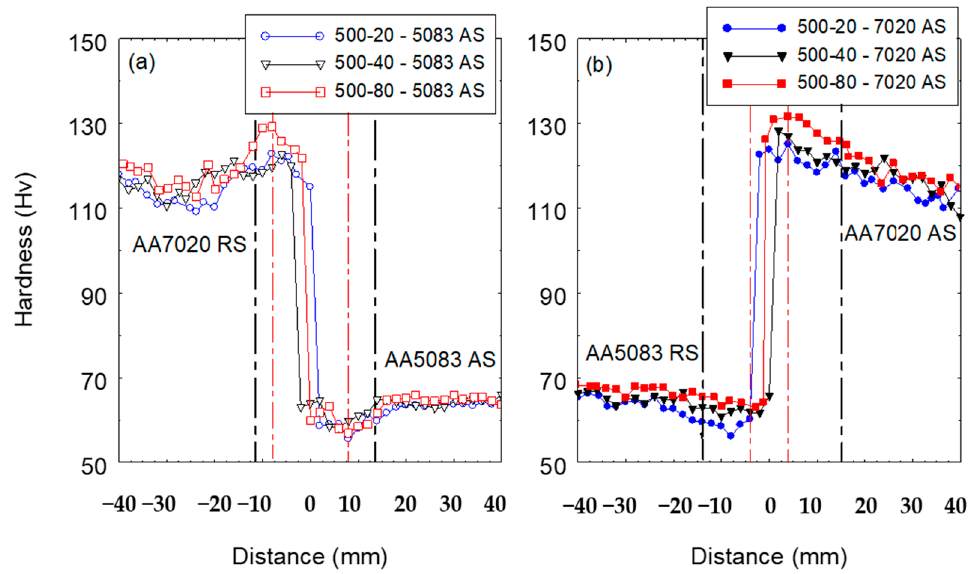
Figure 10. Hardness distribution across the joints ( a ) AA5083/AA7020 and ( b ) AA7020/AA5083 welded at travel speeds of 20, 40 and 80 mm/min showing the effect of the joint arrangement.